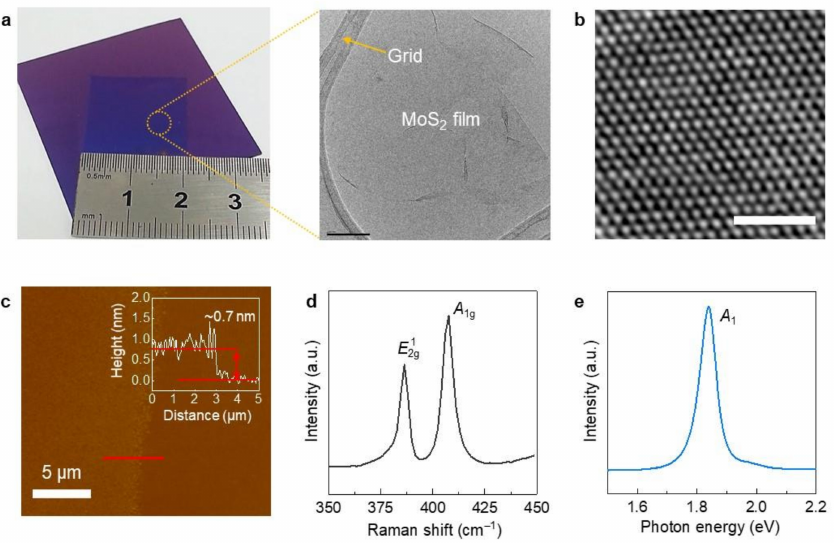
Figure 1. Characterization of MoS 2 monolayer film grown by CVD: ( a ) digital micrograph and TEM images (scale bar denotes 100 nm), ( b ) high-resolution STEM image (scale bar denotes 1 nm), ( c ) AFM image (inset: line profile graph marked by red line), ( d ) Raman spectrum, and ( e ) PL